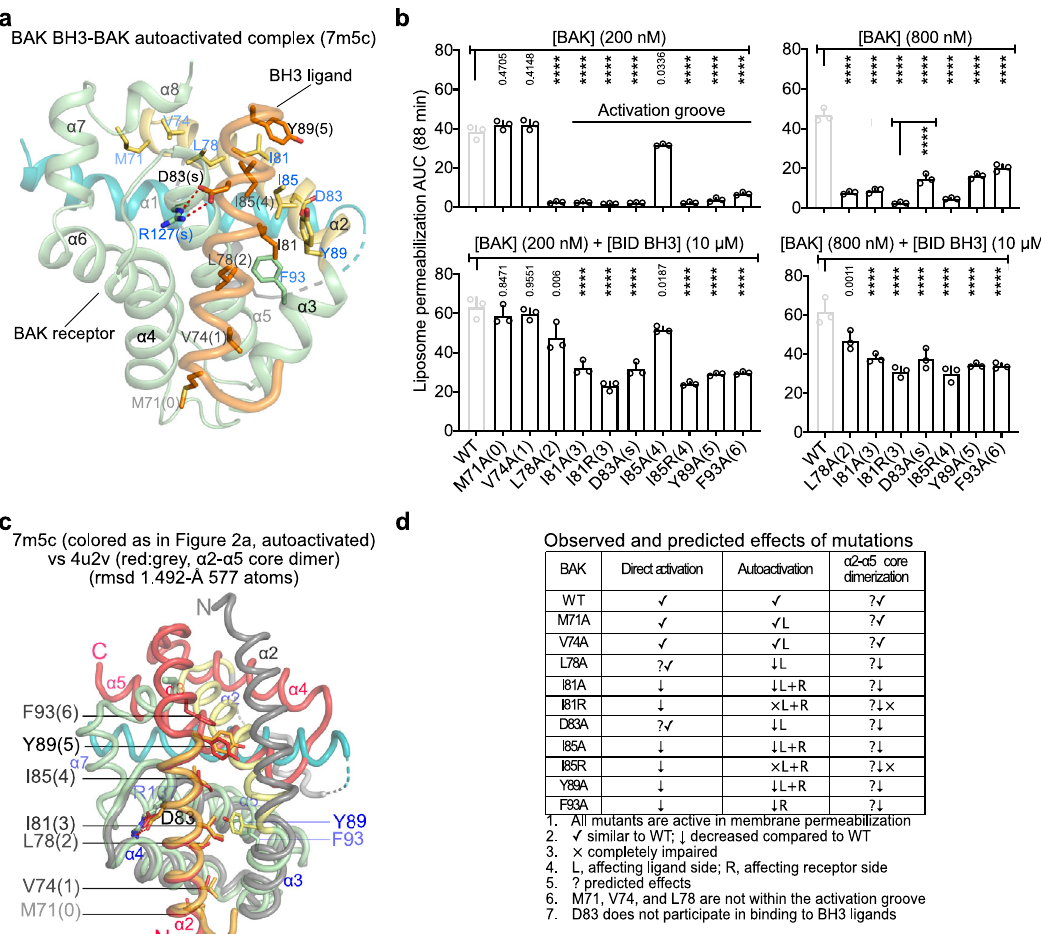
Fig. 2 Direct activation of autoactivation-impaired BAK mutants in vitro. a Cartoon representation of autoactivated BAK identifying residues mutated in BAK BH3 and the activation groove. b Liposome permeabilization assays quanti fi ed as AUC of kinetic traces from Supplementary Fig. 3a at two BAK doses reveal complete and partial impairment in autoactivation (top) and direct activation by BID BH3 peptide (bottom), respectively, for the majority of mutants. Data are presented as mean + SEM of n = 3 experiments each of n = 3 technical replicates. Adjusted p values indicated above each bar were calculated by multiple comparisons using one-way ANOVA with Dunnett (200nM BAK±BID BH3, 800nM BAK + BID BH3) or Tukey test (800nM BAK); **** P <0.0001. 95% con fi dence interval of differences are presented in the Source Data File. c Cartoon representation of BAK BH3-BAK structure overlaid onto that of α 2 – α 5 core BAK dimer. d Summary of observed and predicted (indicated with ? pre fi x) effect of mutations on direct activation, asymmetric BH3-in-groove autoactivation, and symmetric BH3-in-groove α 2 – α 5 core